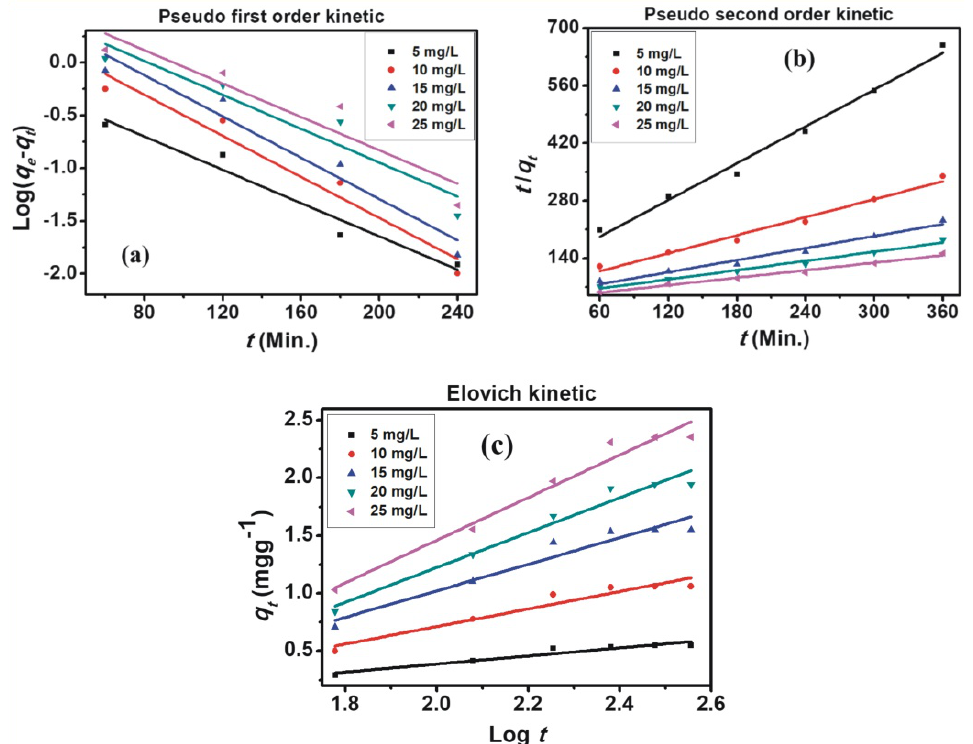
Fig. 3. (a) Pseudo first-order kinetic model, the plot between log ( q